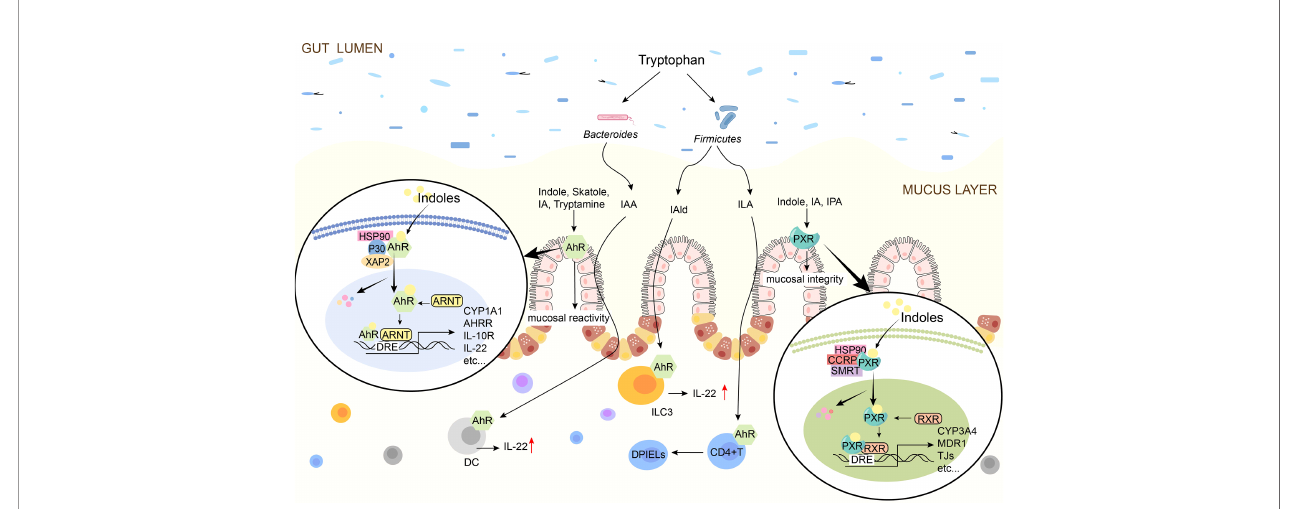
FIGURE 3 | Schematic diagram of indoles signal pathway. Indole, Skatole, IA, Trytamine, IAA, IAld, ILA are AhR ligands. Indoles activates AhR to promote mucosal immunity, and AhR is present on intestinal epithelial cells and immune cells such as ILC3, DC. Indole, IA, IPA are the ligands of PXR and they activate PXR to affect tight junctions. In the absence of ligand, AhR/PXR exists in cytoplasm as an inactive complex. After indoles binding, AhR/PXR enters the nucleus, forms a dimer with ARNT/RXR, and then induces the expression of immune-related genes. IAA, indole-3-acetate; ILA, indole-3-lactate; IAld, indole-3-aldehyde; IA, indole-3-acrylate; IPA, indole-3-propionate; AhR, aryl hydrocarbon receptor; PXR, pregnane X receptor; TJ, tight junctions; IL, interleukin; DC, dendritic cells; DPIELs, double-positive intraepithelial T lymphocytes; ILC3, Group 3 innate lymphoid cells; HSP90, heat shock protein 90; P23, HSP90 co-chaperone p23; XAP2, X-associated protein 2; ARNT, AhR nuclear